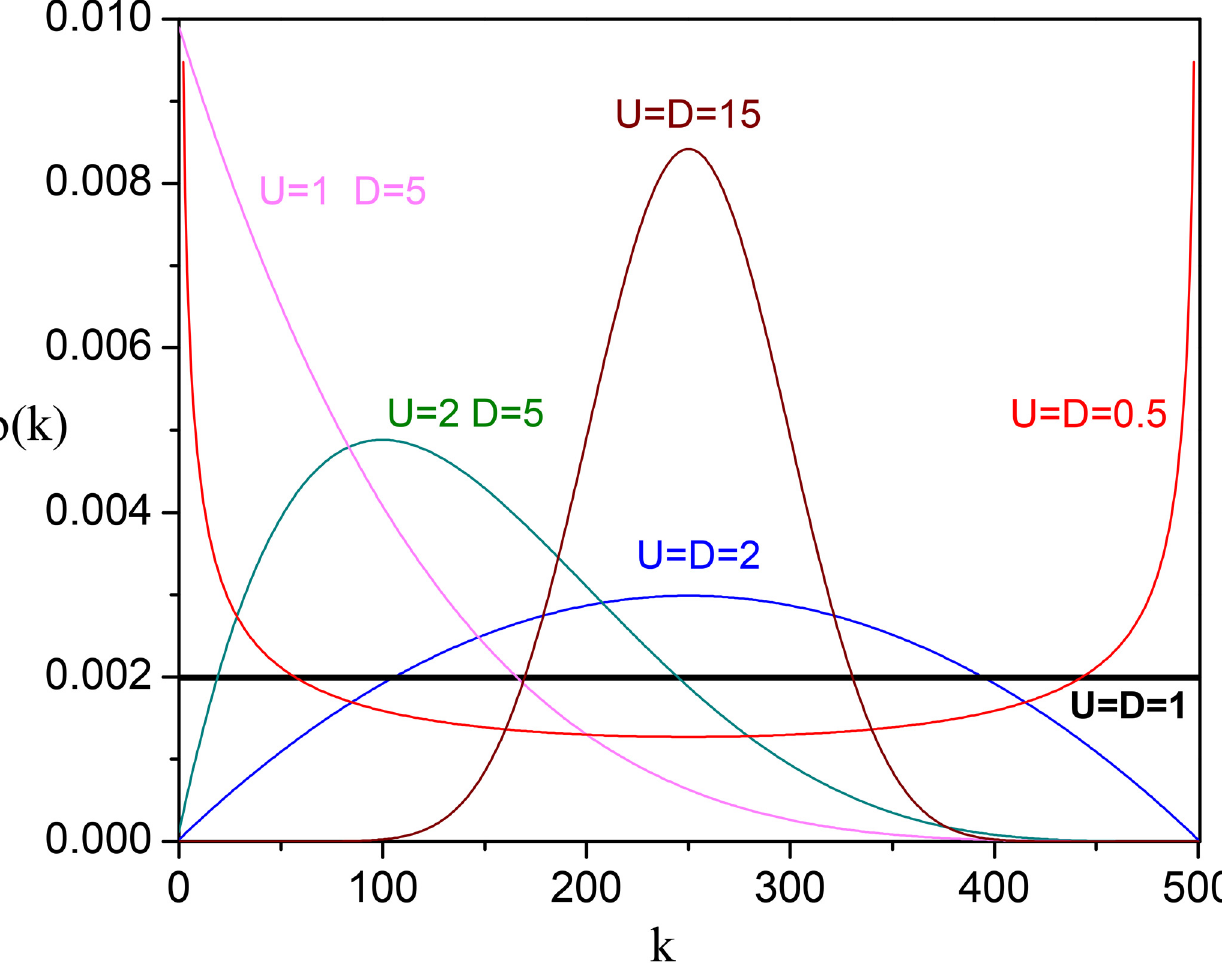
Fig 9. Stationary distributions for different values of U and D . Probability distributions of finding the network with k nodes in state 1 at equilibrium for different values of U and D . The number of variable nodes is N =